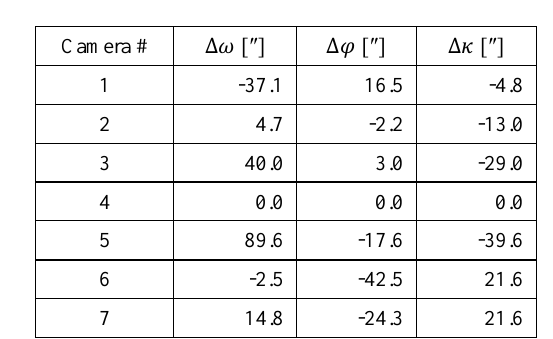
Table 7. Differences in the spatial components of the ROPs between the three-round minor calibration and the full major calibration